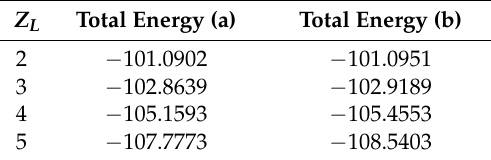
Table 2. Total energy of the electron state is 1 σ 2 2 σ 2 3 σ 2 1 π 4 (in atomic units).